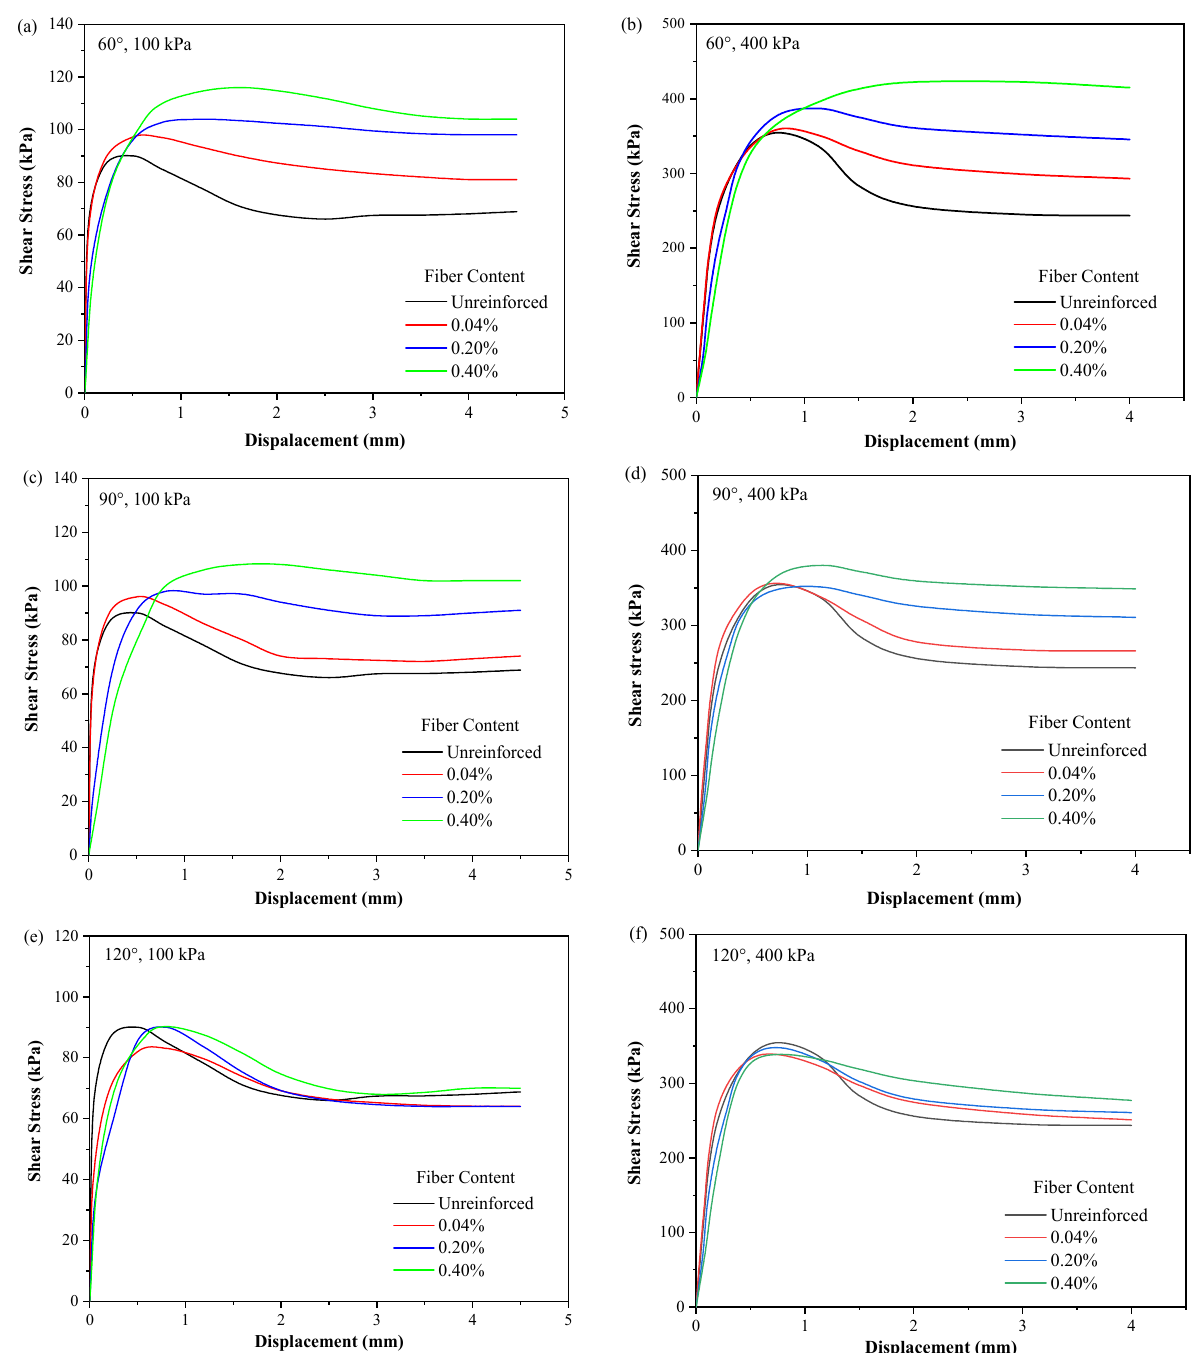
Figure 3. Shear stress–displacement responses of sand specimens in direct shear tests under normal pressure of 100 kPa initially oriented at ( a ) 60°, ( c ) 90°, and ( e ) 120° and under normal pressure of 400 kPa initially oriented at ( b ) 60°, ( d ) 90°, and ( f ) 120°.